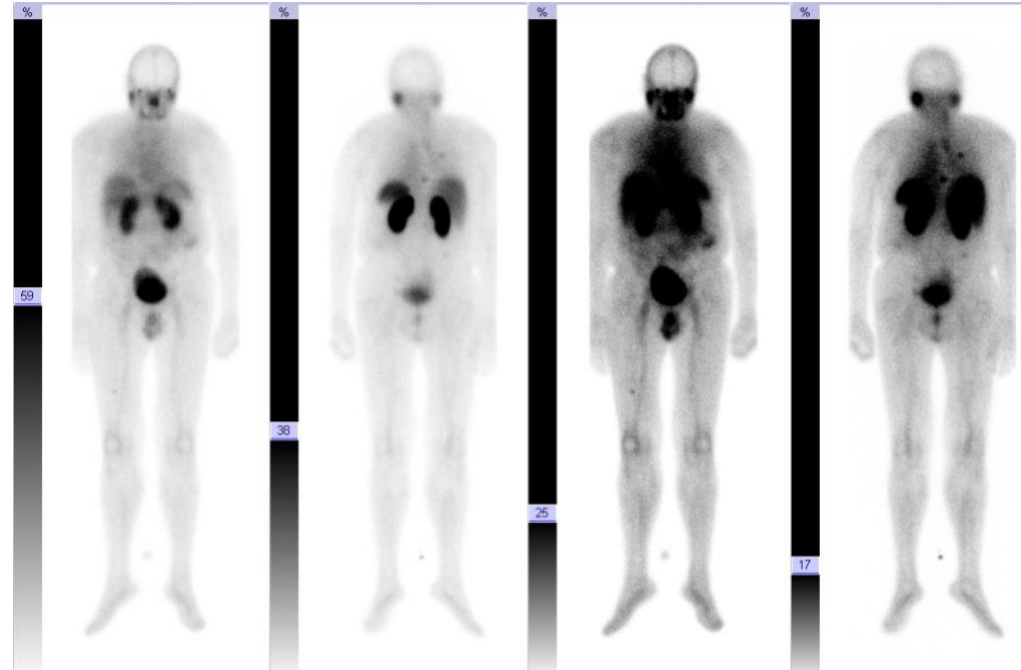
Figure 8. Patient 8. Whole-body-scan 90 min post first 177 Lu-PSMA application with an intensive accumulation in the metastases.